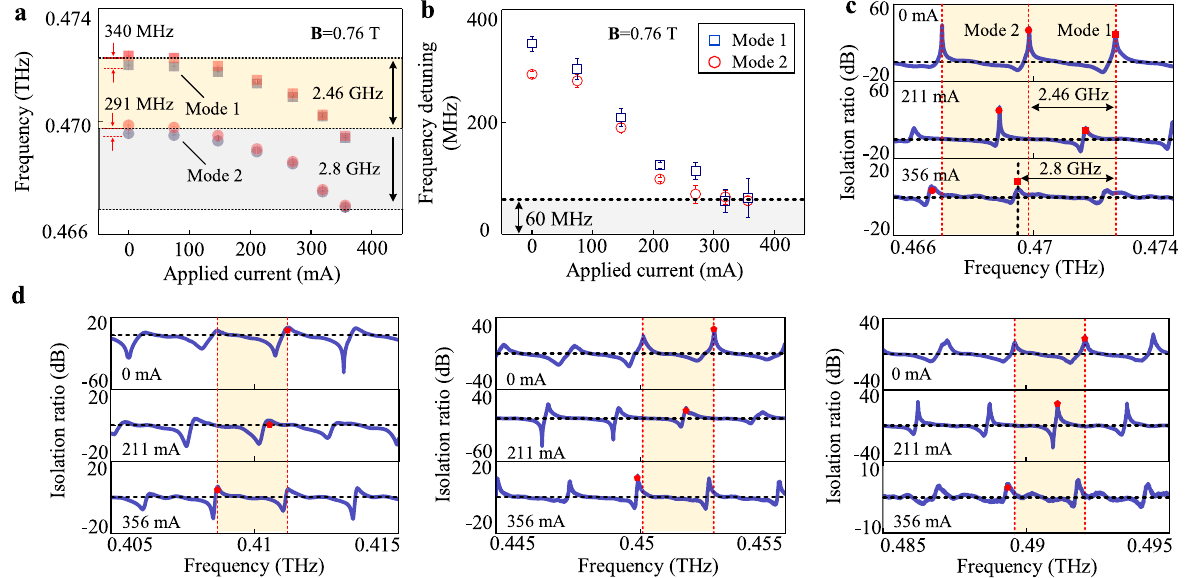
Fig. 4 Electrically driven tunability of the terahertz isolator. a Resonant frequencies of two adjacent modes with the change of the applied current when B = 0.76 T. The error bars represent the standard deviations of three measurements of central frequencies. In a , blue dots refer to the CW direction and red dots refer to the CCW direction. In a and b , the square points are marked as mode 1, and the circle points refer to mode 2. b Frequency detuning between CW and CCW directions ( F CCW – F CW : F refers to the resonant frequencies) with the variety of the applied current when B = 0.76T. The error bars represent the standard deviations of three measurements of frequency detunings. c Isolation ratios of the chip in the change of the applied current (0, 211, 356 mA). d Isolation ratios in the change of the applied current (0, 211, 356 mA) at different operation frequencies, frequency windows are 0.405 – 0.415, 0.445 – 0.455, and 0.485 – 0.495 THz. Table. 1 Comparison between reported terahertz isolators and the isolator in this